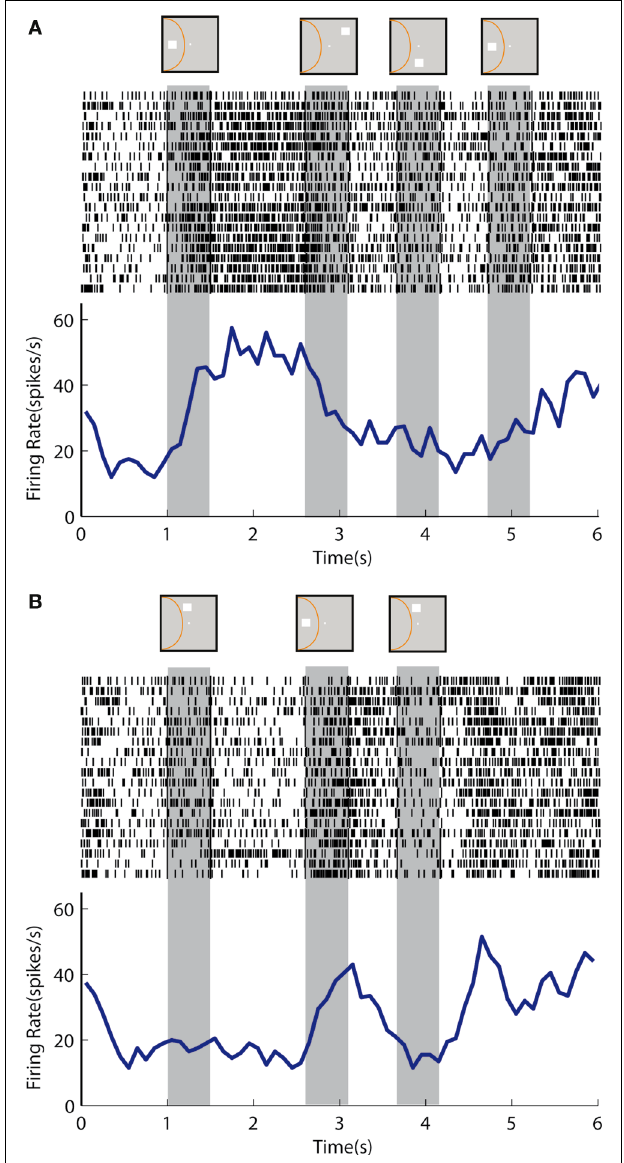
FIGURE 9 | Rasters and histograms of one neuron with sustained activity recorded from area 7a of the posterior parietal cortex, tested with the delayed match-to-sample task. Data are shown from the Match/Nonmatch task. (A) Responses to a cue presentation in the receptive fi eld followed by nonmatch presentations out of the receptive fi eld. (B) Responses to a cue presentation out of the receptive fi eld followed by a nonmatch stimulus in the receptive fi eld.